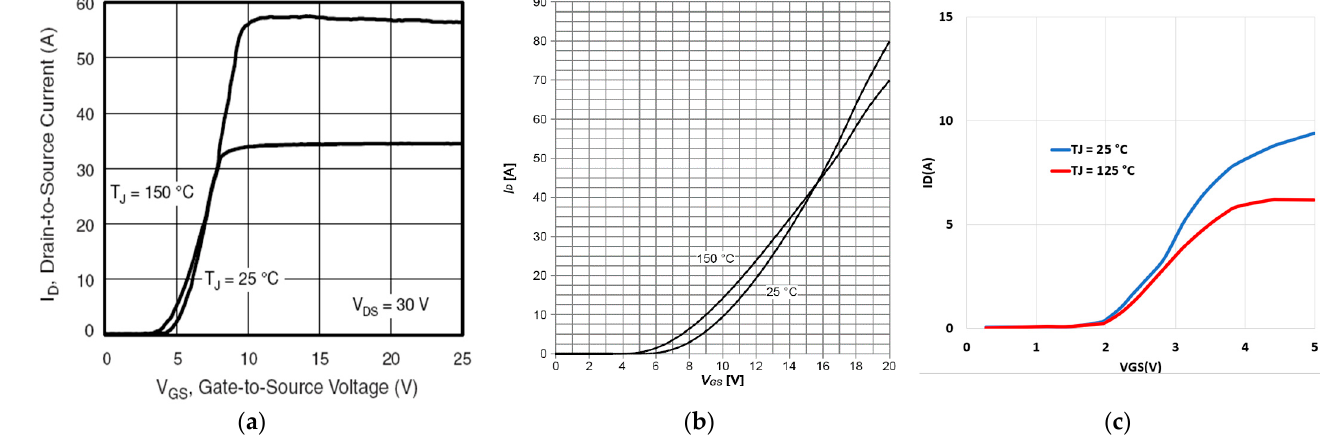
Figure 3. Typical transfer characteristics at different temperatures: ( a ) Si MOSFET (Vishay SiHB22N65E) [38]; ( b ) SiC MOSFET (Infineon IMZA65R107M1H) [39]; ( c ) GaN HEMT (GaNPower GPI65008DF56) [40].